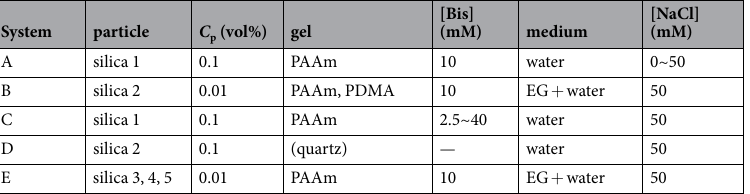
Table 2. Composition of the experimental systems used in the